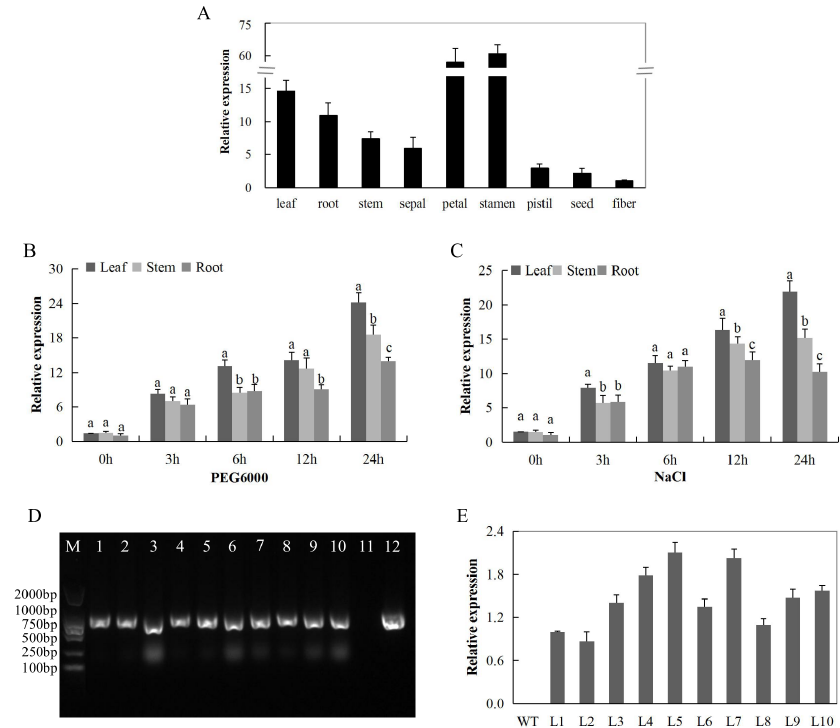
Figure 8. The RT-qPCR analysis of the expression of the cloned gene ( A ) Total RNA isolated from various tissue of cotton plant under normal conditions; ( B ) Total RNA extracted from drought-stressed cotton seedlings ( C ) Total RNA extracted from salt-stressed cotton seedlings; ( D ) Polymerase chain reaction (PCR) analysis performed to check 1299 bp coding sequence (CDS) integration in transformed T 1 generation, number 1–10 transgenic Arabidopsis lines, 11 negative control (wild type) and 12 is the positive control ( pWM101-Gh_D12G2017 (CDKF4) ( E ) The gene expression levels of the Gh_D12G2017 (CDKF4) of T 2 transgenic Arabidopsis lines analyzed through RT-qPCR, in three biological replicates. Different letters (a, b, and c) indicate significant differences between expression levels of the gene in different tissues of the Gh_D12G2017 (CDKF4) overexpressed Arabidopsis lines (ANOVA; p <